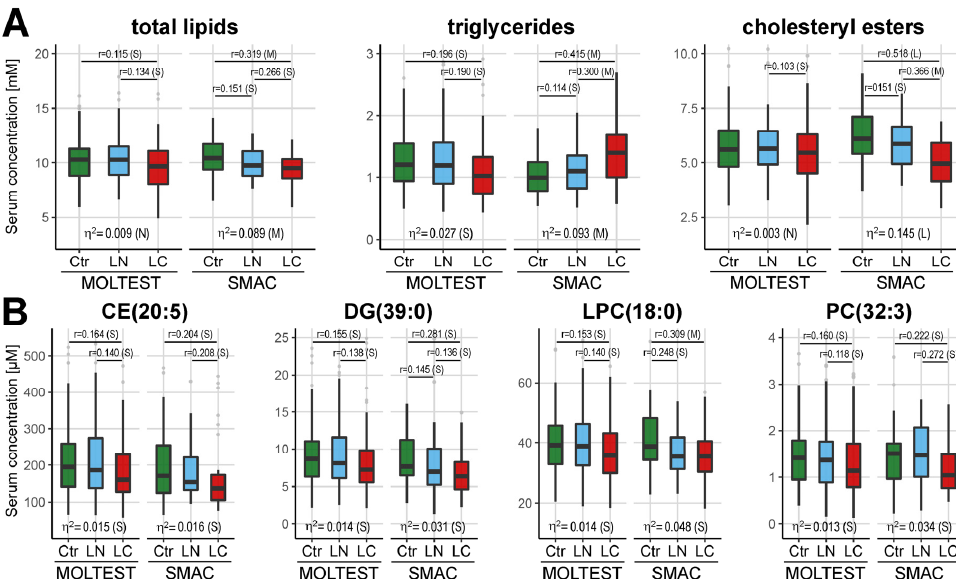
Figure 3. Levels of selected metabolites separately in two cohorts participating in lung cancer screening programs: ( A )—aggregated concentration of total lipids, triglycerides, and cholesteryl esters in serum samples of healthy controls (Ctr), individuals with benign lung nodules (LN), and lung cancer patients (LC). ( B )—concentration of selected compounds in serum samples from three analyzed groups. Boxplots show the minimum and maximum values, lower and upper quartile, and median (outliers are marked with gray circles); represented are the eta squared effect size values for a general variance and the Pallant r effect size for a significance of differences between pairwise compared groups ( n = 123 and 31 in each group for MOLTEST and SMAC cohort,